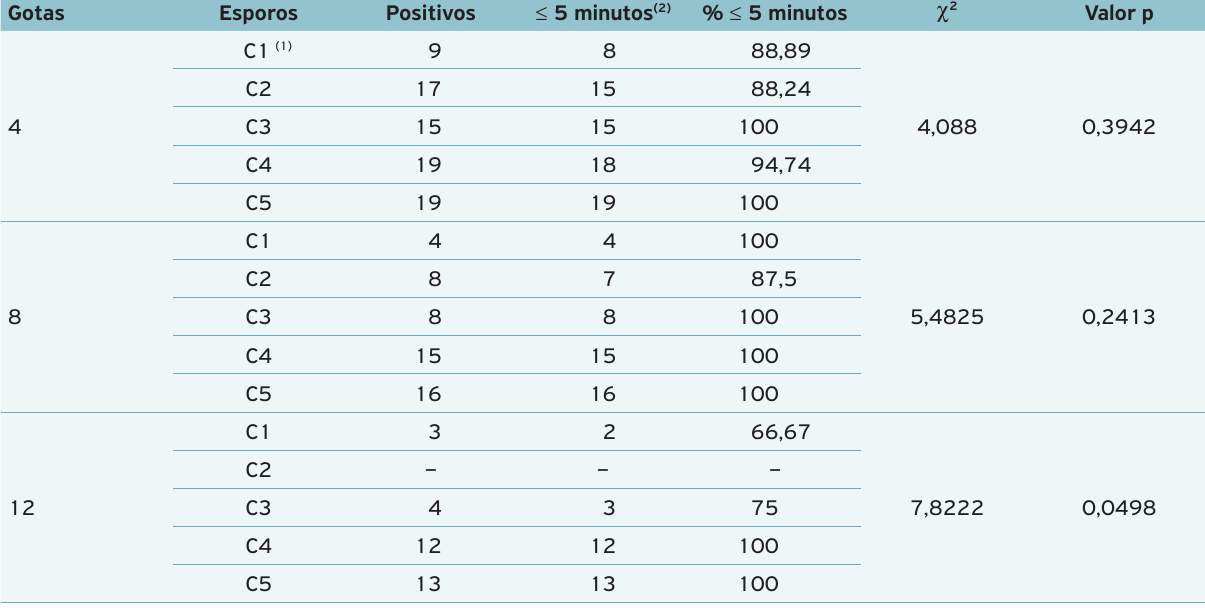
Tabela 4. Comparação entre as classes de número de esporos dentro do número de gotas da solução extratora utilizada, para o tempo de ocorrência dos resultados positivos, pelo teste do qui-quadrado a 5% de